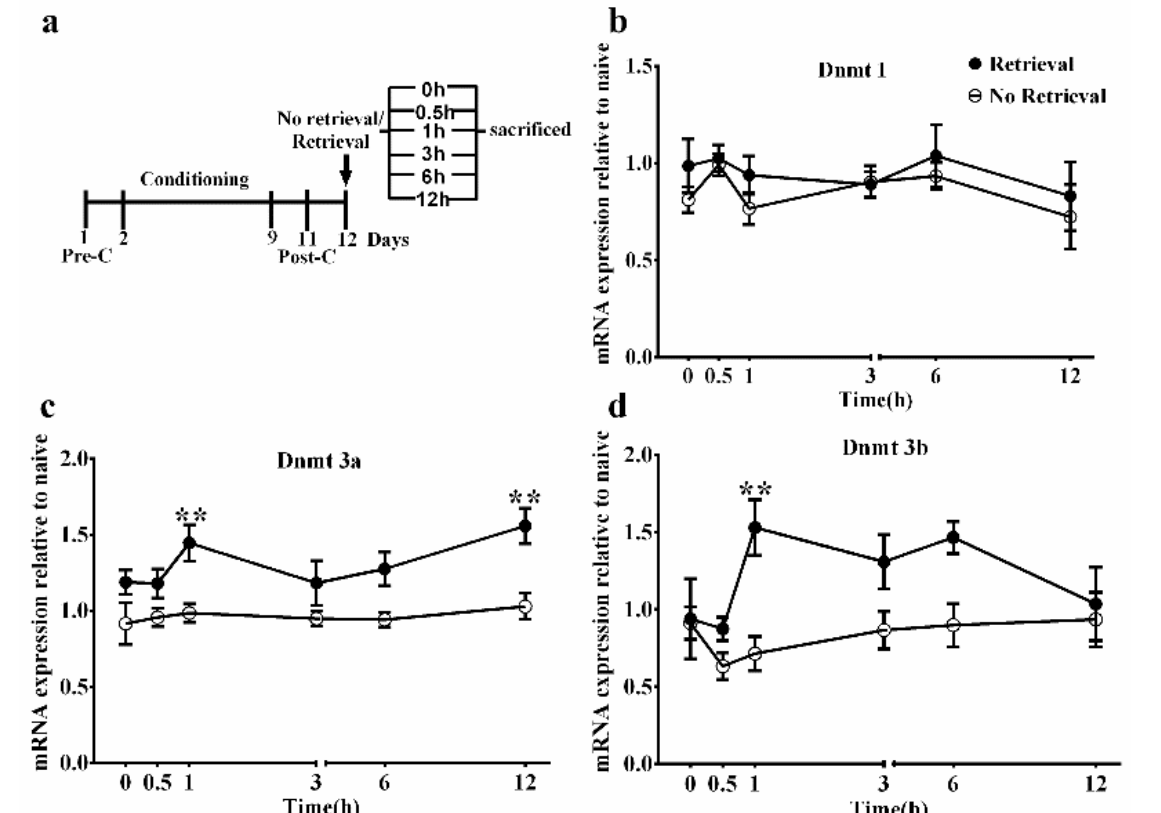
Figure 3. Transcription regulation of DNA methyltransferase genes (Dnmts) by morphine-associated memory reconsolidation in the basolateral amygdala (BLA). ( a ) Timeline of the experimental procedure. ( b – d ) Reverse transcription PCR analysis of Dnmt1 ( b , n = 9–10), Dnmt3a ( c , n = 9–10), and Dnmt3b ( d , n = 8–10) mRNA expression in the BLA during reconsolidation. Data are expressed as the mean ± SEM. ** p < 0.01, compared to no-retrieval group at the same time-point.